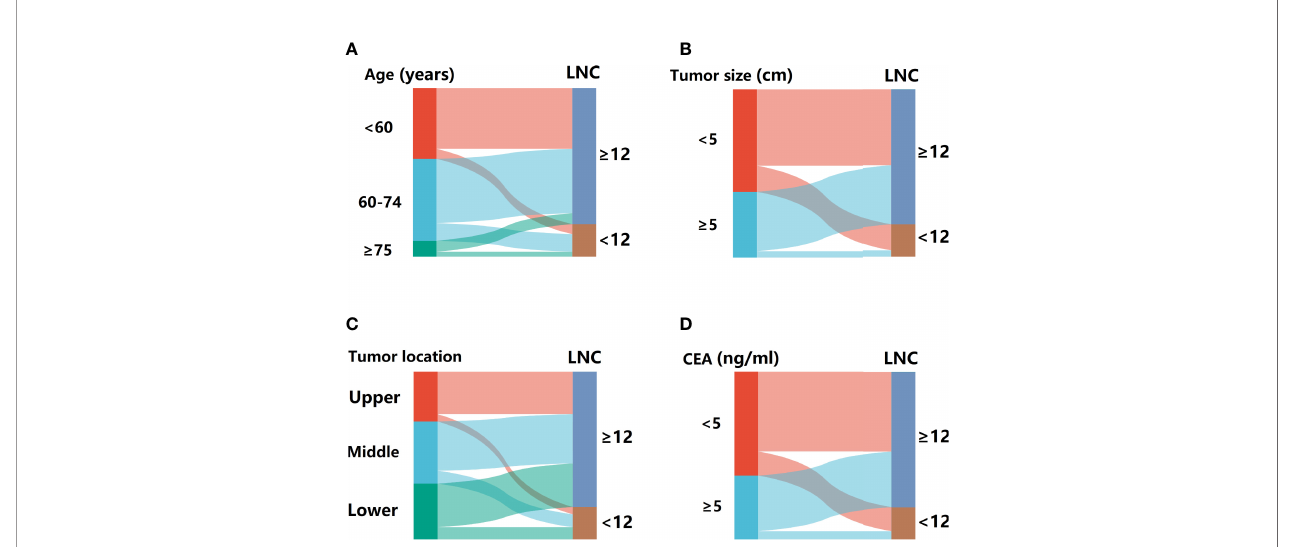
FIGURE 2 | The Sankey diagram for the proportion of patients with LNC < 12 in different subsets. (A) Strati fi ed by age. (B) Strati fi ed by tumor size. (C) Strati fi ed by tumor location. (D) Strati fi ed by